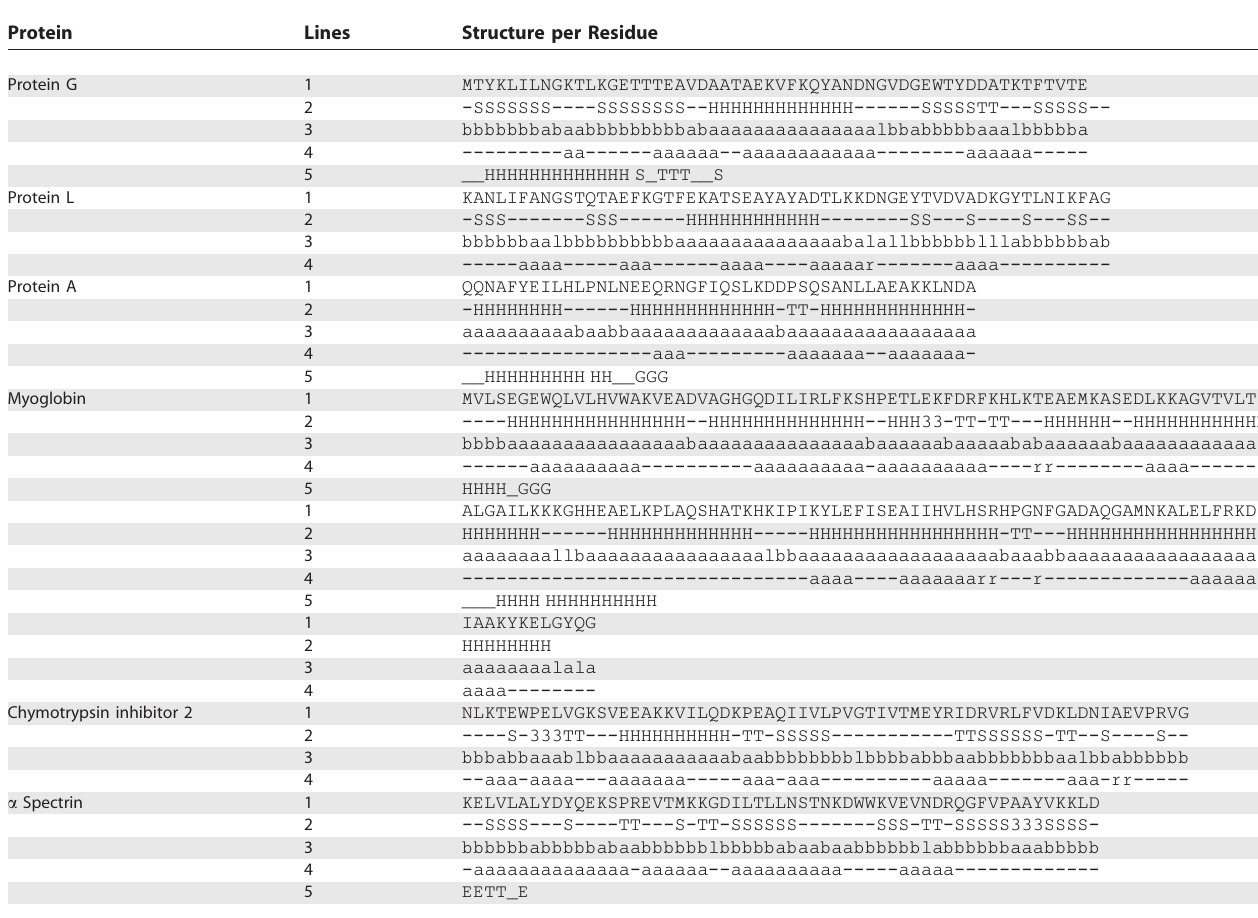
Table 5. Comparison of the Structural Bias with the Native Structure Protein Lines Structure per